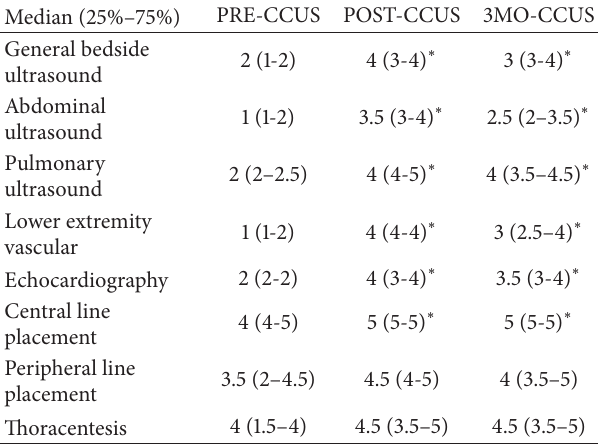
Table 3: Comfort level of performing specific ultrasound applica- tions using 5-point Likert scale (1 = strongly disagree, 2 = disagree, 3 = neither disagree nor agree, 4 = agree, and 5 = strongly agree). Results reported as median (25th to 75th percentiles). “PRE-CCUS” group was tested within 1 week before CCUS course, “POST-CCUS” group was tested within 1 week after CCUS course, and “3MO- CCUS” group was tested 3 months after CCUS course. ∗ 𝑝 < 0.05 when compared to PRE-CCUS data.